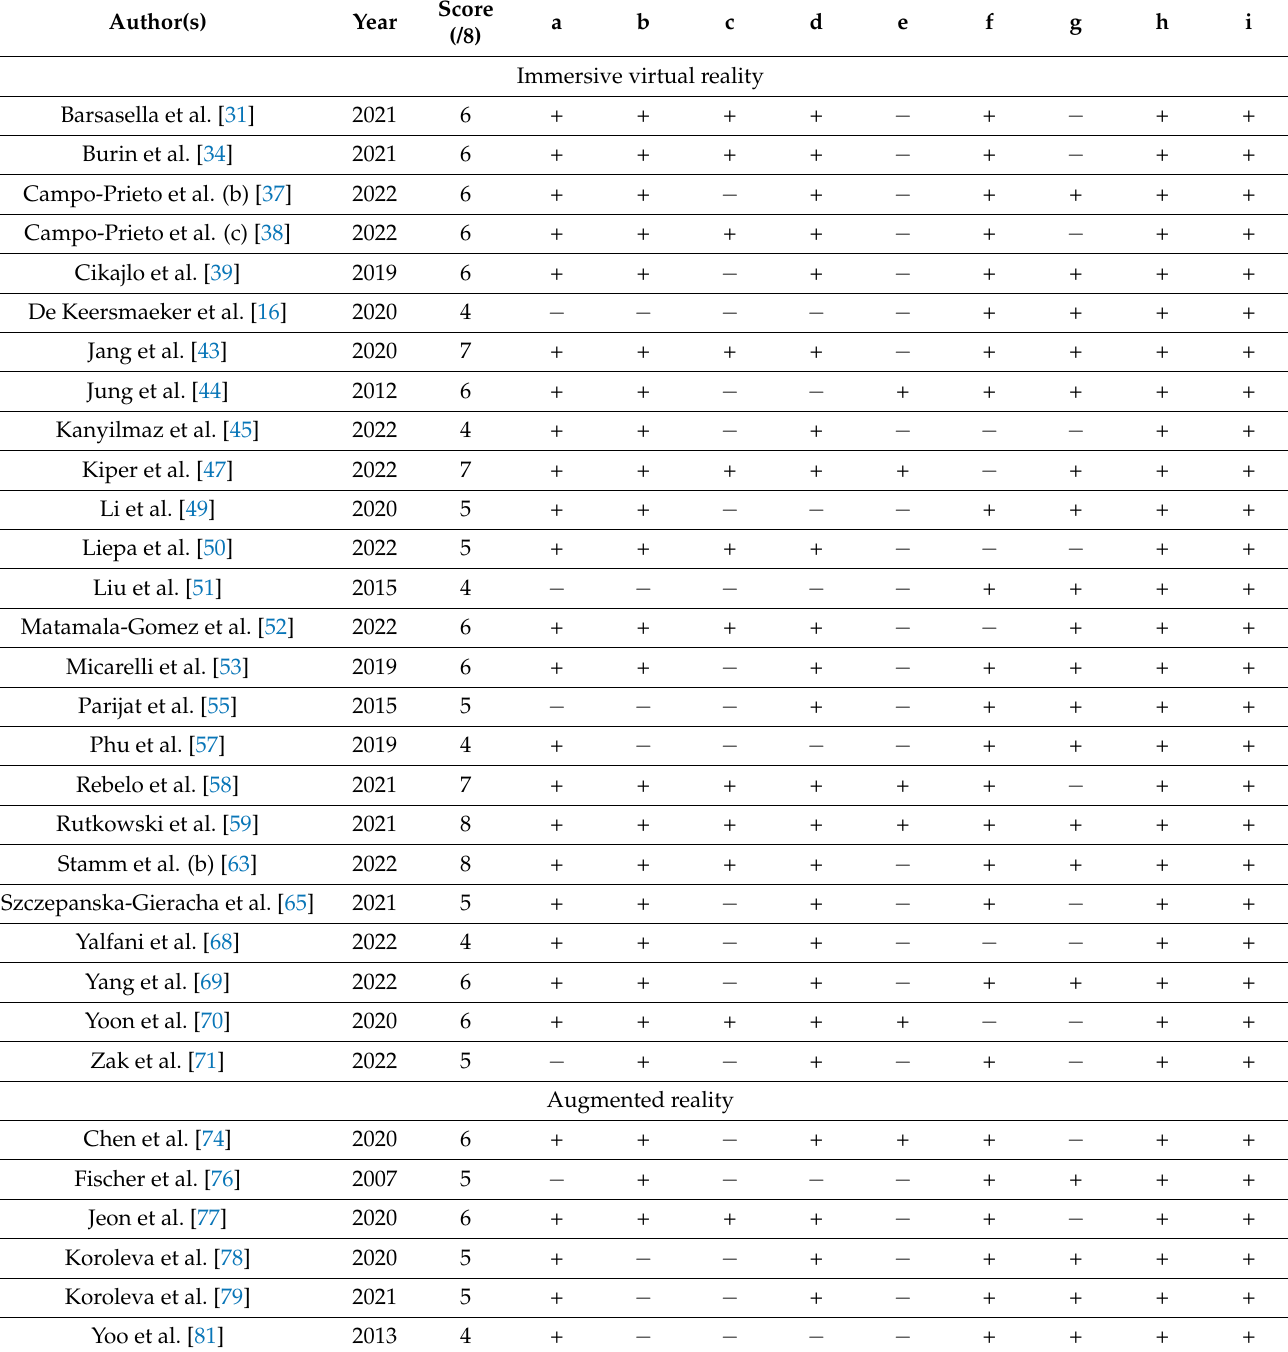
Table 2. PEDro scale rating for experimental